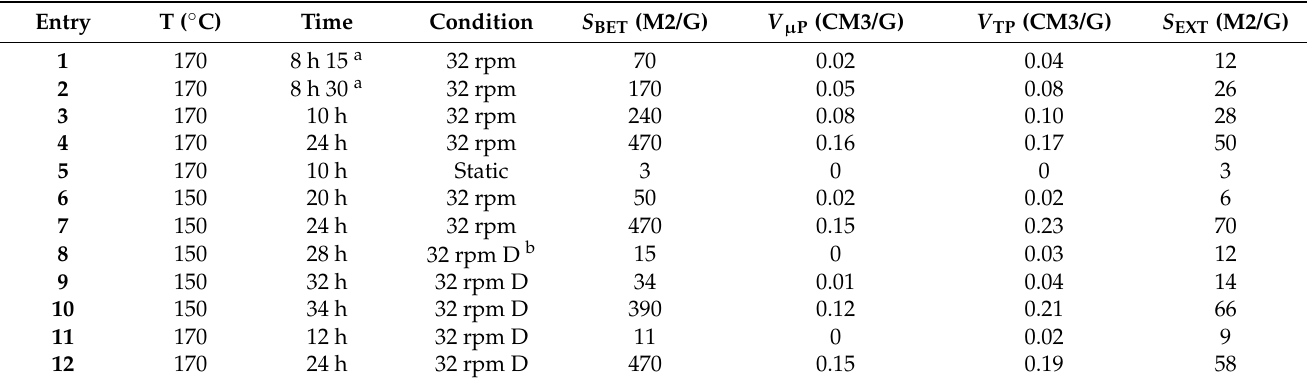
Table 1. Textural properties of synthesized